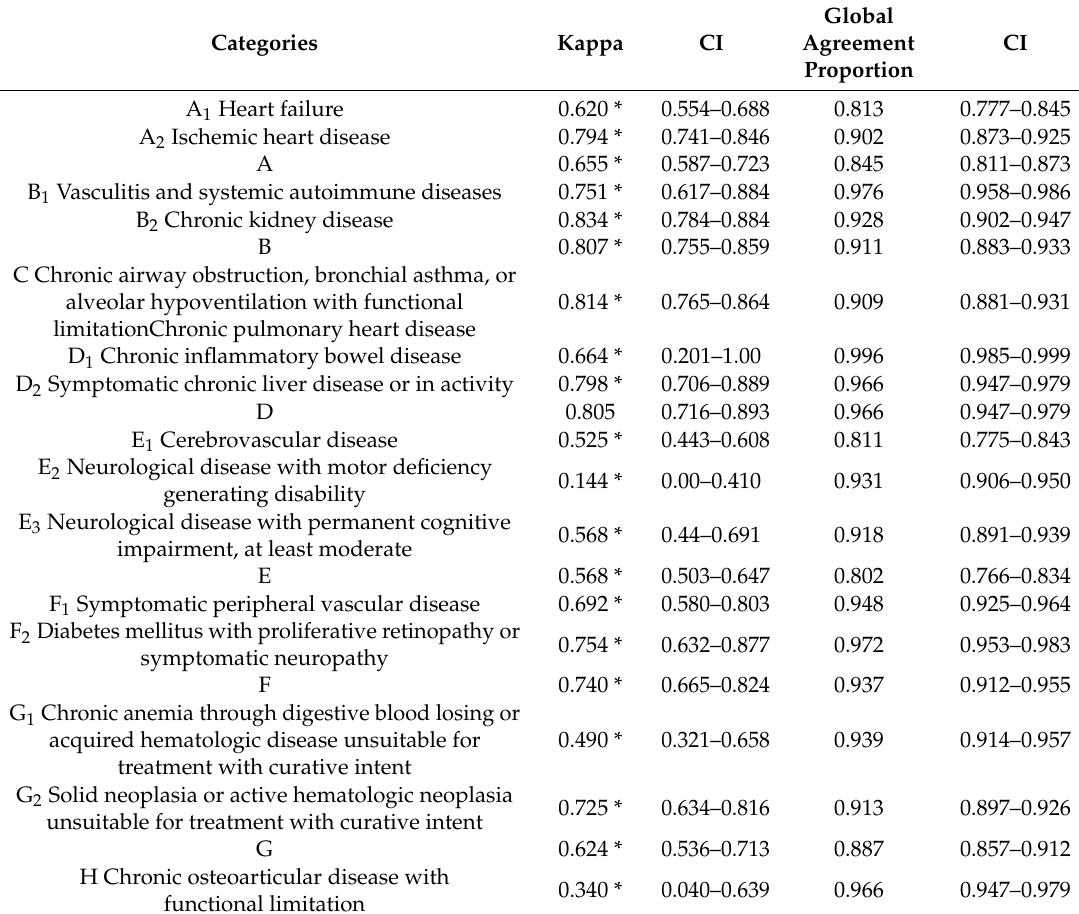
Table 2. Concordance between the PP classification according to clinical criteria and ICD-9-CM codes by